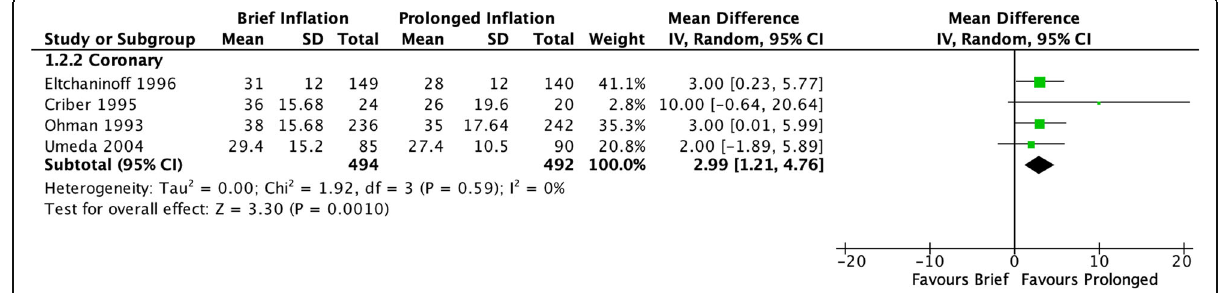
Fig. 3 Severity of residual stenosis after angioplasty inflation, measured as a continuous outcome of percent